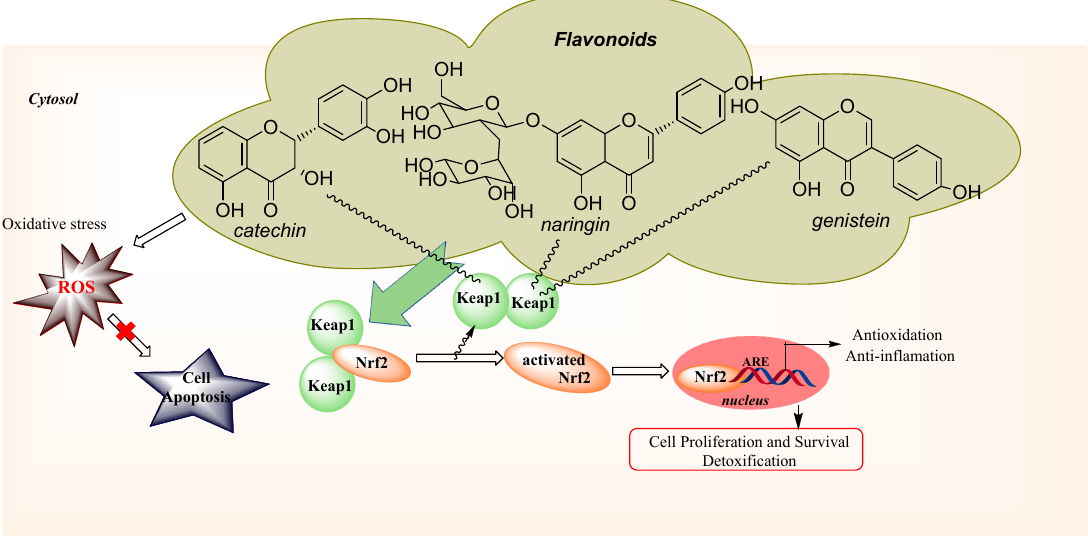
Figure 10. Schematic model representation of flavonoids mechanism involved in antioxidative defense.